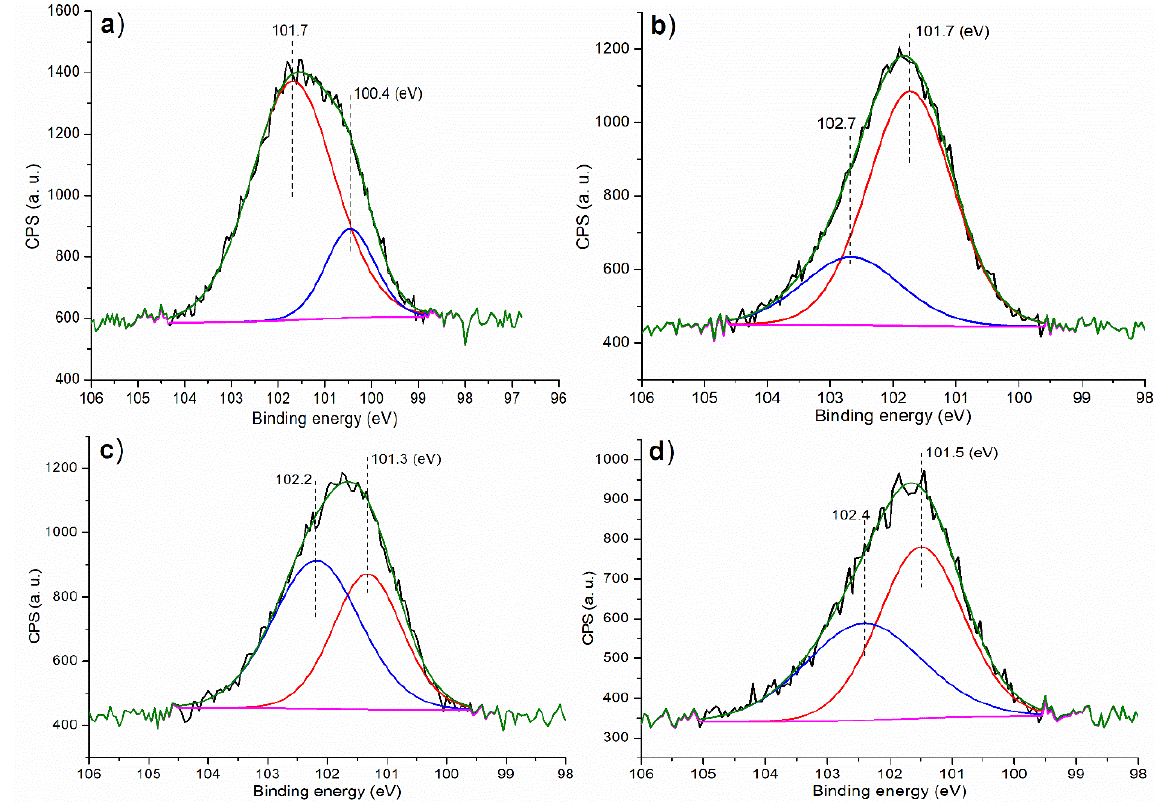
Figure 4. XPS measurements of the Si 2p region: ( a ) cement, ( b ) sample 2, ( c ) sample 7, and ( d ) sample 10.